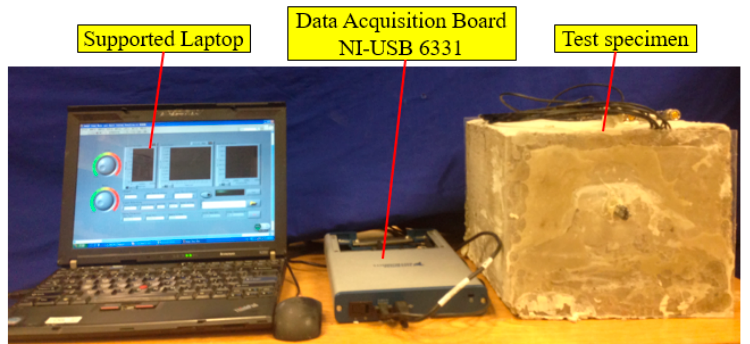
Figure 8. Experimental setup.